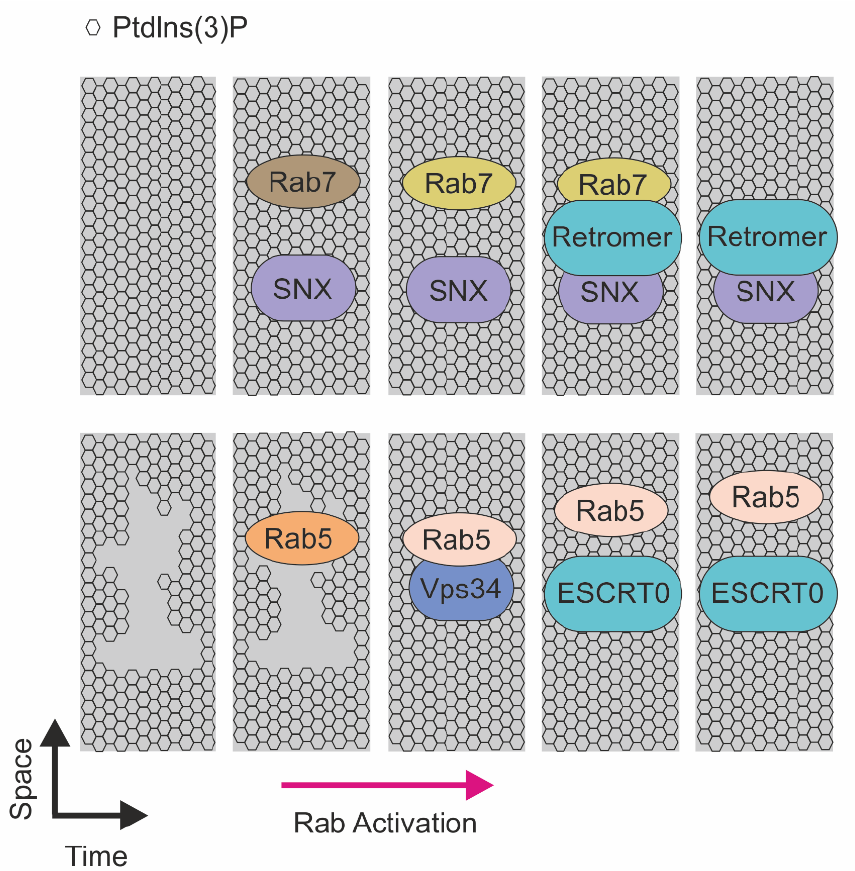
Figure 3. Schematic representation of the RABs-mediated recruitment of sorting machineries on the endosomal membrane. (Top) Recruitment of sorting machineries in function of RAB7. SNX and RAB7 recruitment on the membrane enriched in PtdIns(3)P that, in a sequential manner, mediate endosomal recycling. Activated RAB5 recruits Vps34 and induces PtdIns(3)P production, this event allows ESCRT0 to recognize ubiquitinated proteins on endosome membrane enriched in PtdIns(3)P and direct to lysosome for degradation.